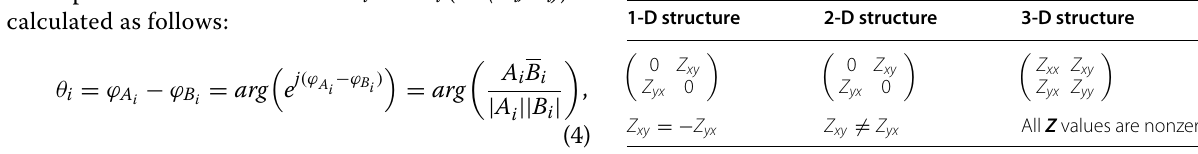
Table 1 Impedance tensor characteristics in certain geological situations. In the 1-D case, the impedance of the diagonal elements is zero. In the 2-D case, when the observation axes coincide with the geoelectrical strike, the impedance is zero in the diagonal elements, and the off-diagonal elements are unequal. In the 3-D case, all Z values are nonzero 1-D structure 2-D structure 3-D